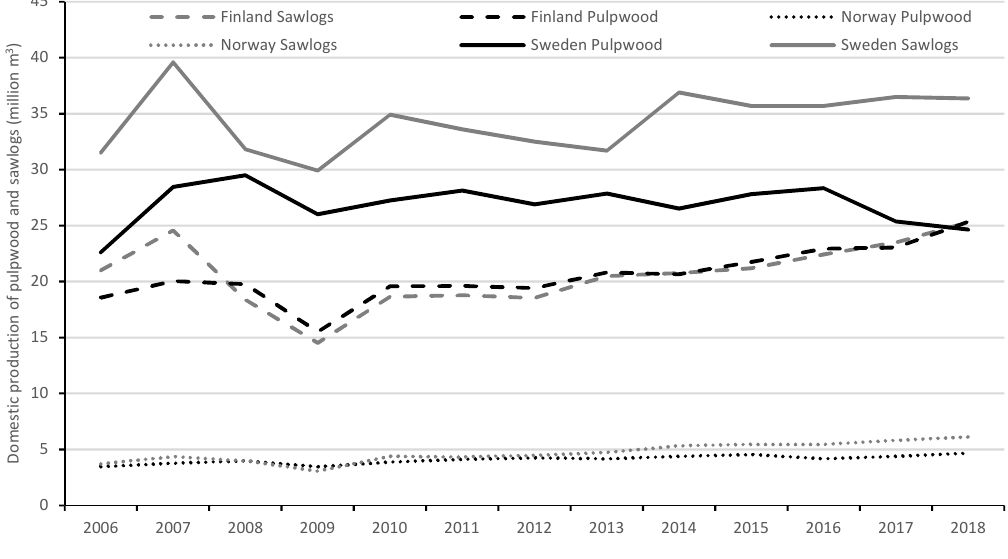
Figure 1. Production volumes of pulpwood and sawlogs in Norway, Finland and Sweden, 2006–2018 (million m 3 ) Sources: [15].